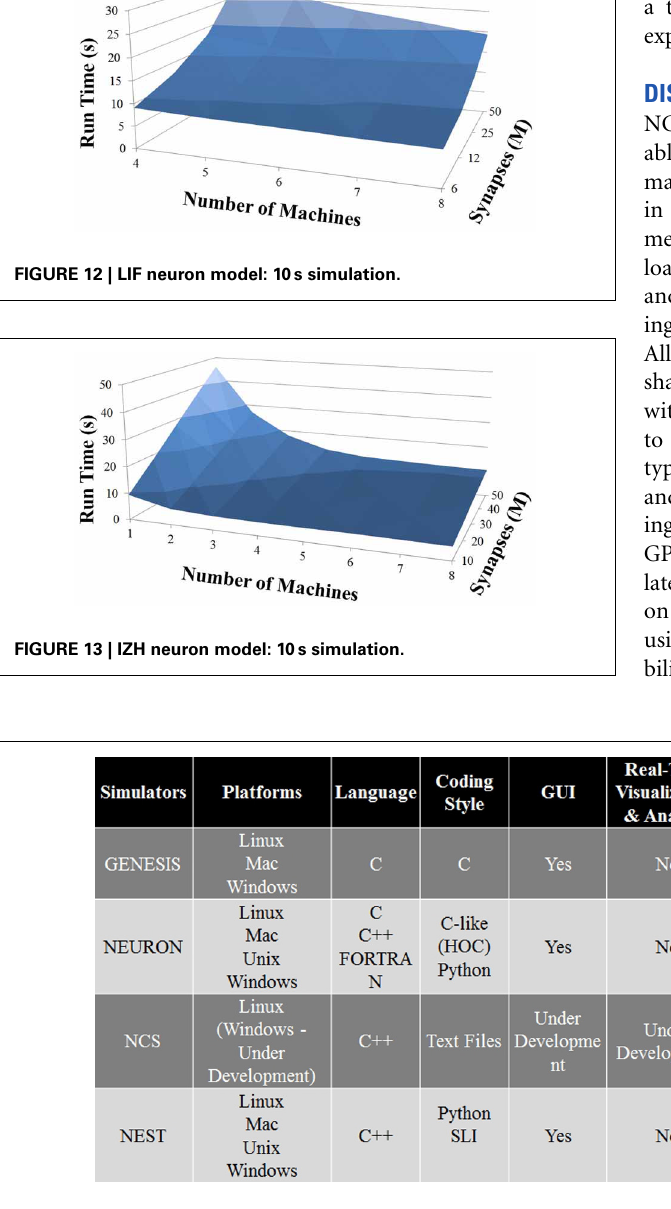
FIGURE 14 | Simulation environments